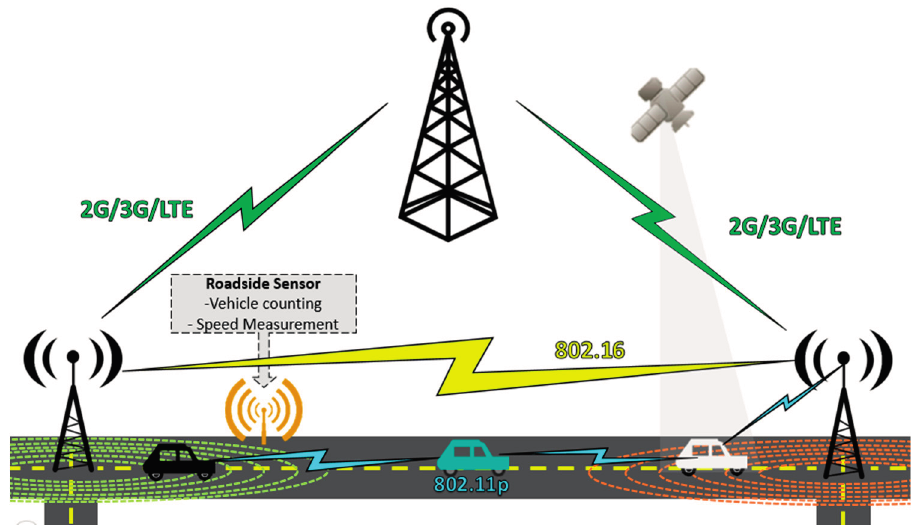
Figure 13. Supporting communication infrastructure.